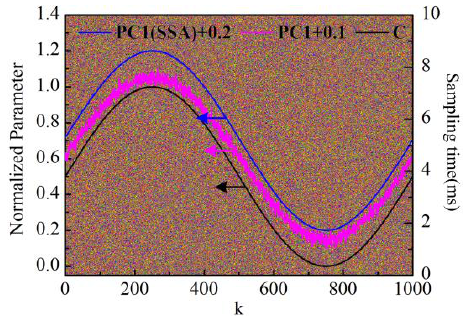
Figure 4. Comparison of the calculated results. SSA: Singular spectrum analysis. PC1(SSA) + 0.2: PC1 loading curve after SSA processing with a bias of 0.2; PC1 + 0.1: PC1 loading curve with a bias of 0.1; C: Capacitance variation curve.